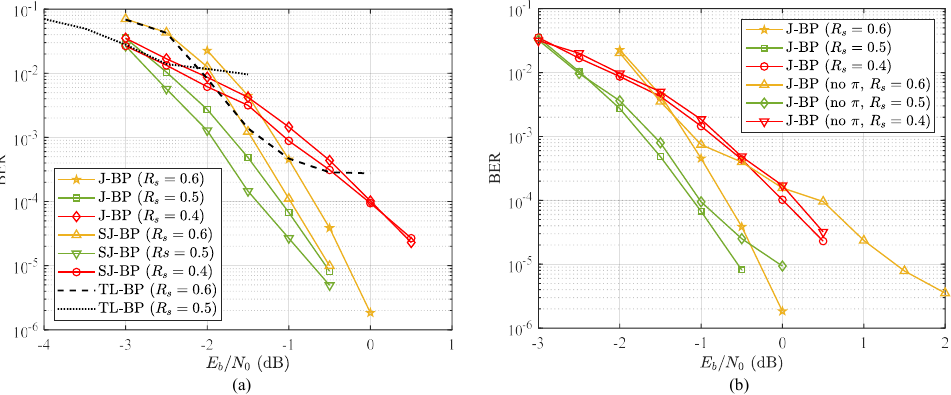
Figure 5. BER performance comparison: ( a ) J-BP decoding, SJ-BP decoding and TL-BP decoding; ( b ) J-BP decoding vs J-BP (no π ) decoding